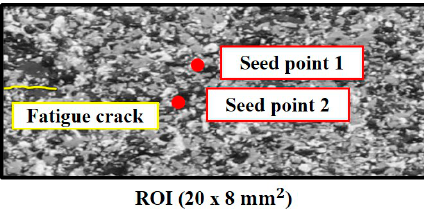
Figure 11. Randomly selected two seed points in the ROI of the fatigue crack specimen.